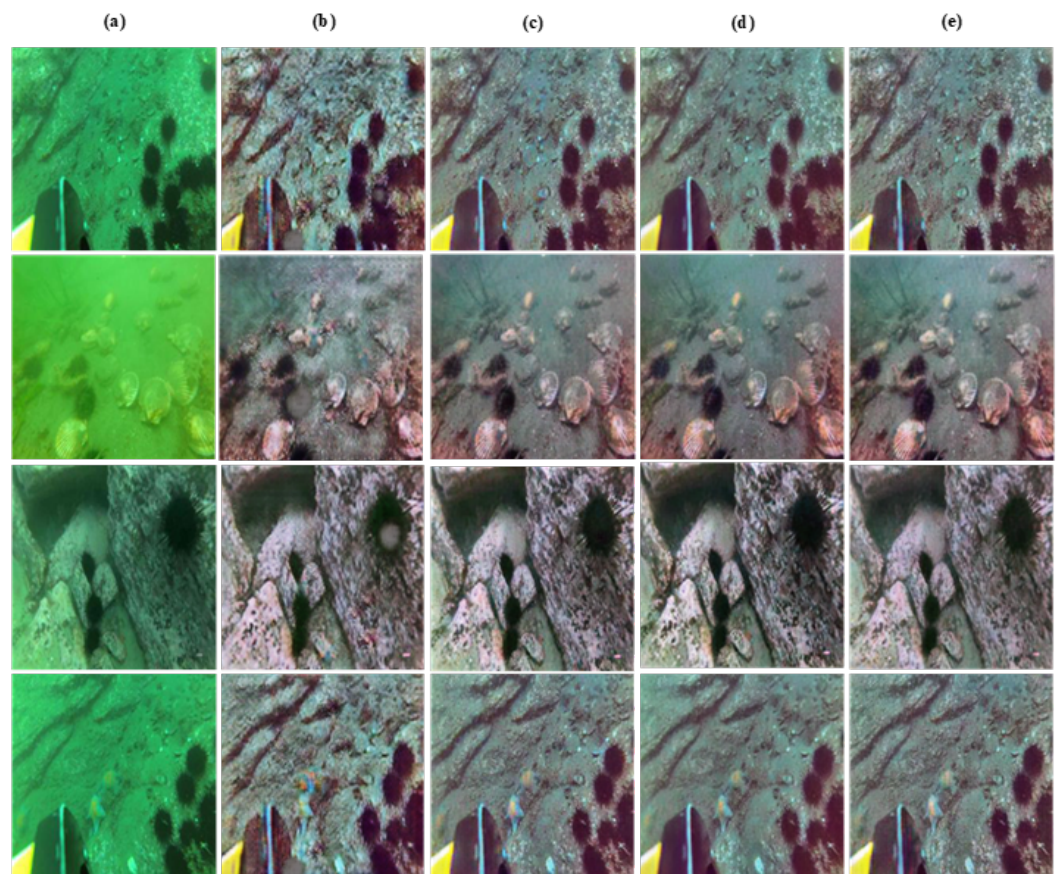
Figure 7. Ablation experiments: ( a ) input image, ( b ) w/o L Content , ( c ) w/o L Blur , ( d ) G ResNet , and ( e )